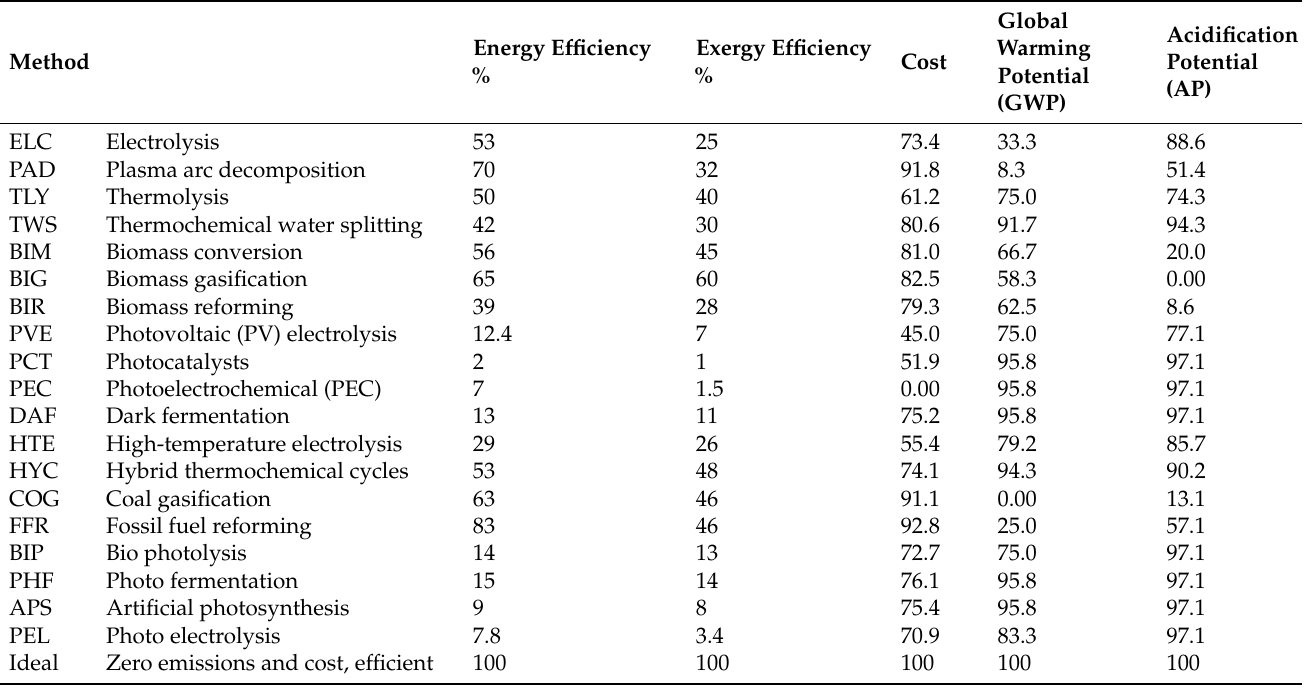
Table 4. Comparison of the energy and exergy efficiencies of some hydrogen production methods. Reprinted with permission [1,50,51].